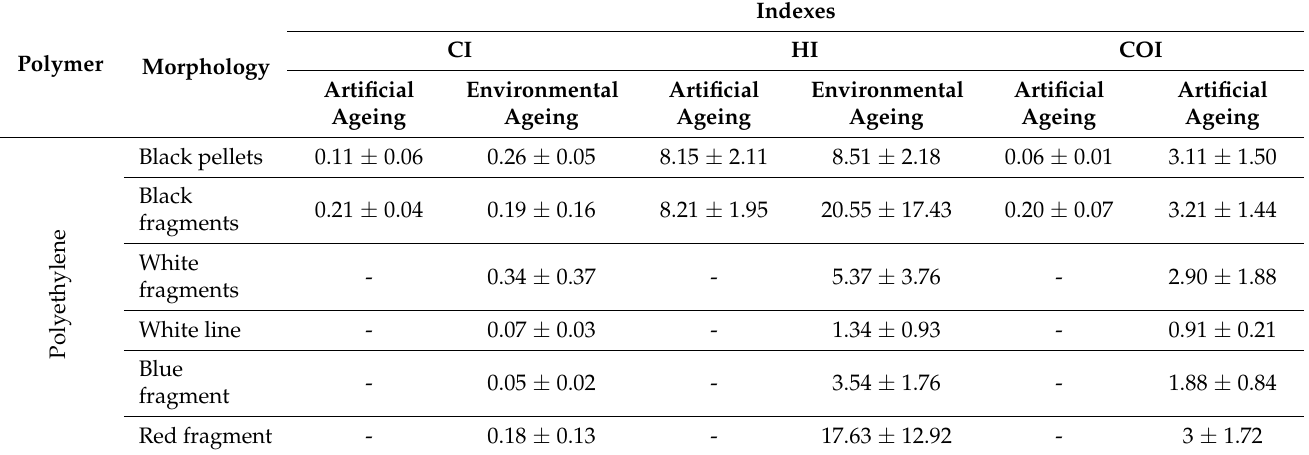
Table 5. Comparison of CI, HI, and COI calculated for freshwater PE particles collected from the Ofanto river and artificial aged PE pellets and